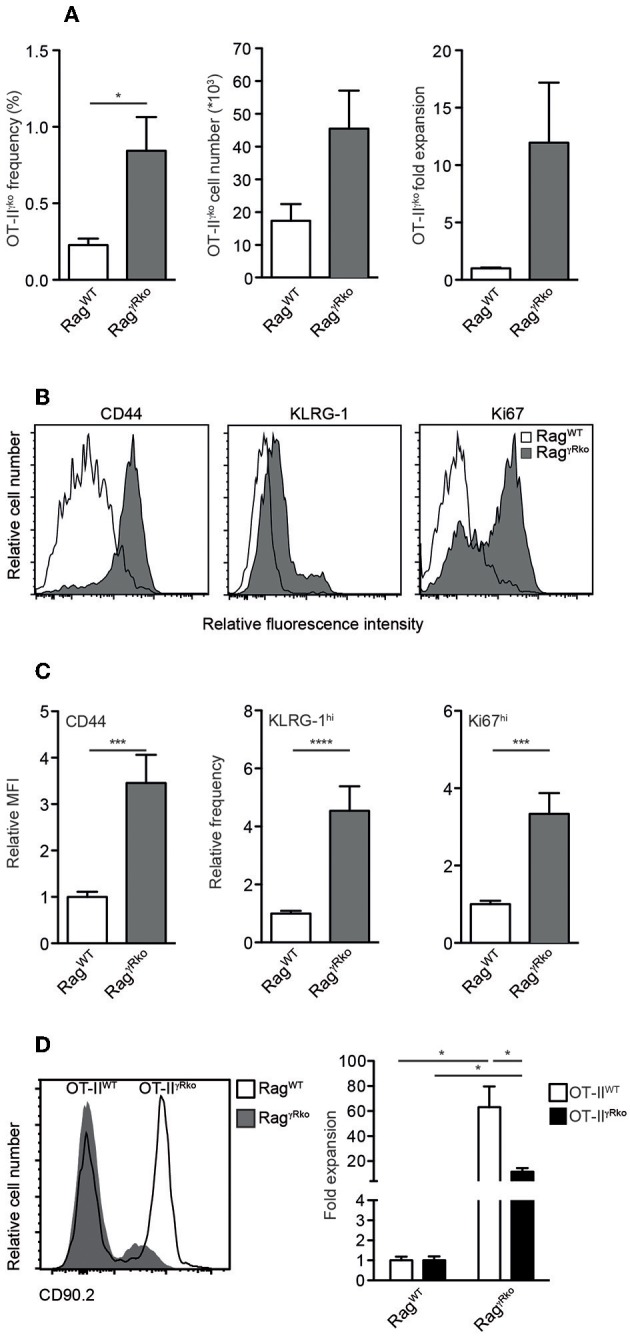
CD4+ T cell-derived IFN-γ promotes SP in an autocrine manner. (A–C) OT-IIγko (3–4 independent experiments with 12–17 mice per group) or (D) equal numbers of Thy1.1+ OT-IIWT and Thy1.1/1.2+ OT-IIγRko T cells (4 mice per group) were transferred simultaneously into Thy1.2+ RagWT and RagγRko mice. After 11–12 days, recipient splenocytes were analyzed by flow cytometry as described in Figure 1. Overlay shows the relative abundance of Thy1.1+ OT-IIWT and Thy1.1/1.2+ OT-IIγRko T cells in RagWT and RagγRko mice. (A,C,D) Graphs show mean values + SEM; *p ≤ 0.05; ***p ≤ 0.001; ****p ≤ 0.0001.